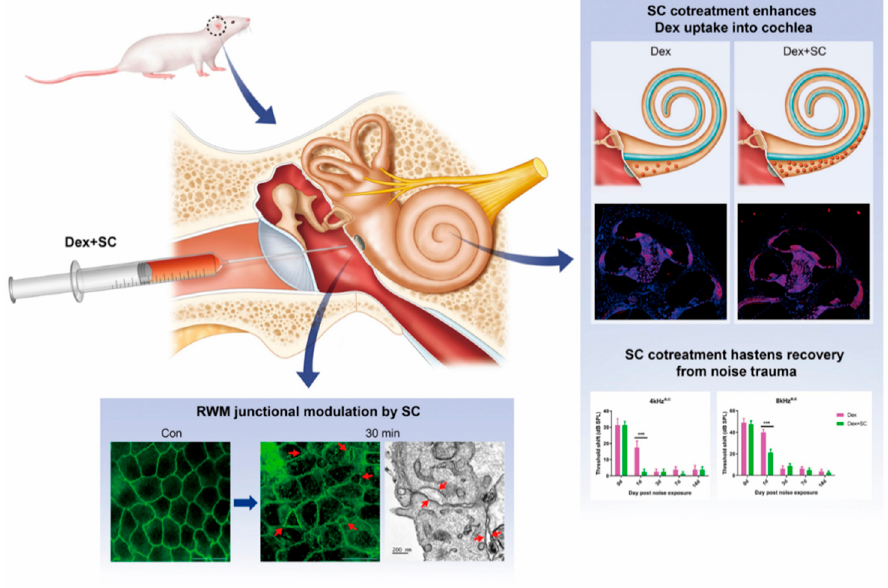
Figure 7. RWM junctional modulation improves dexamethasone uptake into the inner ear and shows faster recovery after noise-induced hearing loss. Diagram of the summary by which SC cotreatment increases dexamethasone concentration into the perilymph and cochlea. Junctional modulation by SC cotreatment in rats, therefore, improves hearing and hastens recovery from noise